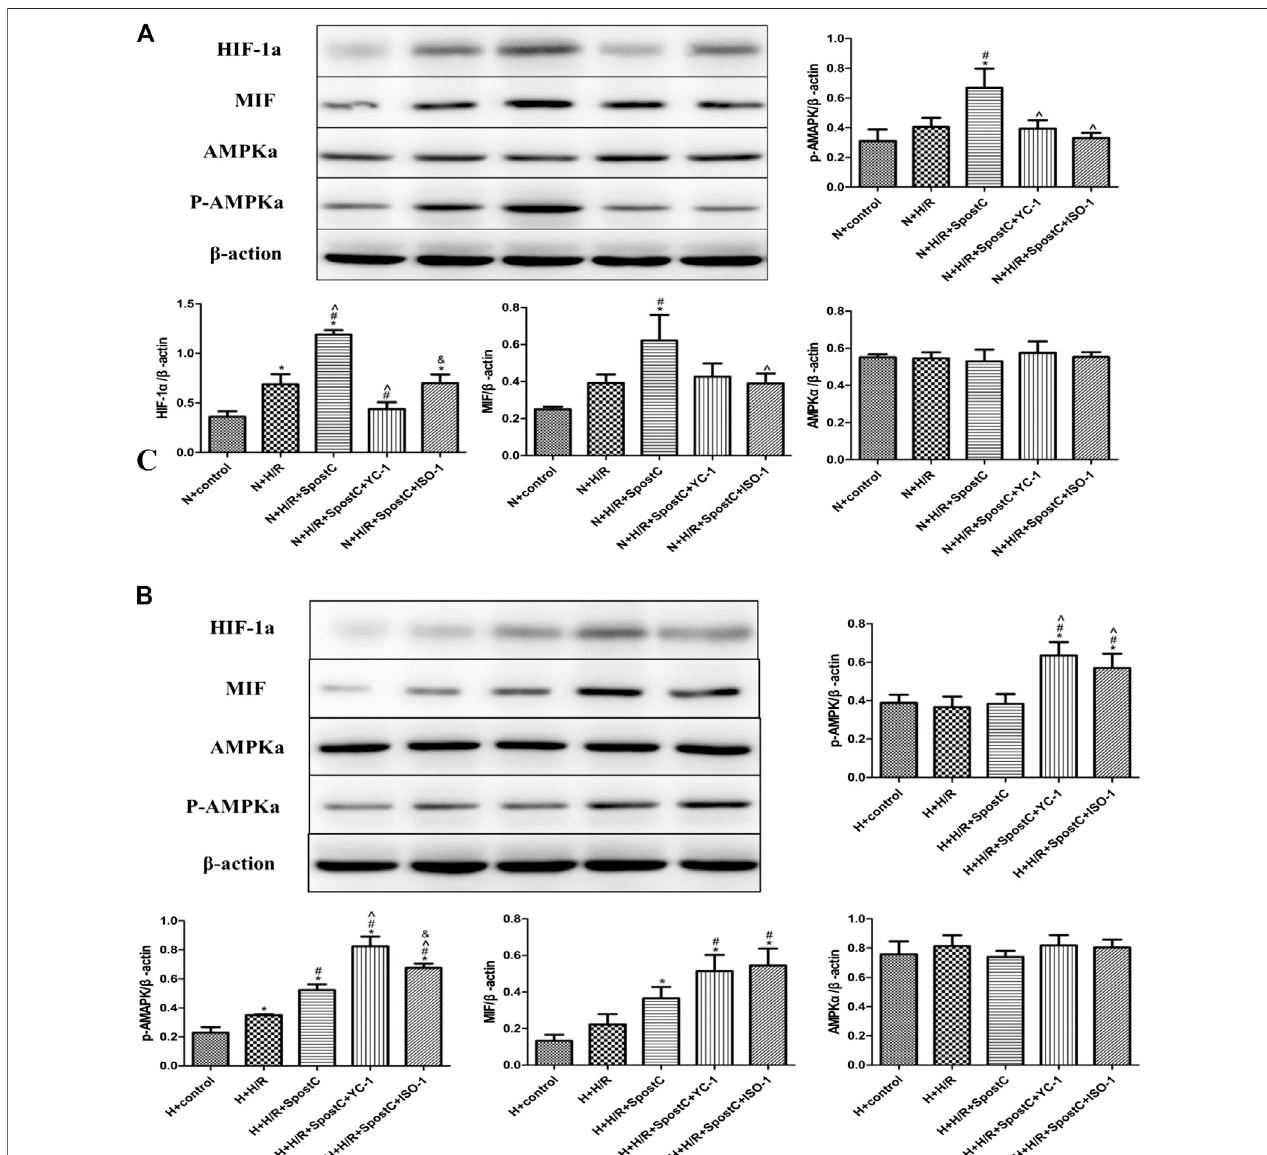
FIGURE 4 | SPostC exerts its cardioprotective effect by HIF-1 α /MIF/AMPK signal pathway under low glucose condition, but the function is inactivated under high glucose condition. (A) Western blot images of each group under normal glucose condition; (B) Western blot images of each group under high glucose condition; Under normal culture, SPostC signi fi cantly upregulated HIF-1a, MIF and p-AMPK α protein expression. After YC-1 and IOS-1 administration, the expression of HIF-1a MIF and p-AMPK α wasdownregulated.Datarepresentmean ± SD,vs.N+CONgroup* p < 0.05;vs.N+H/Rgroup # p < 0.05;vs.N+H/R+SPostCgroup ^ p < 0.05;vs.N + H/R + SPostC + YC-1 group & p < 0.05; vs. H + control group a P < 0.05; vs. H + H/R group b P < 0.05; vs. H + H/R + SPostC group c P <